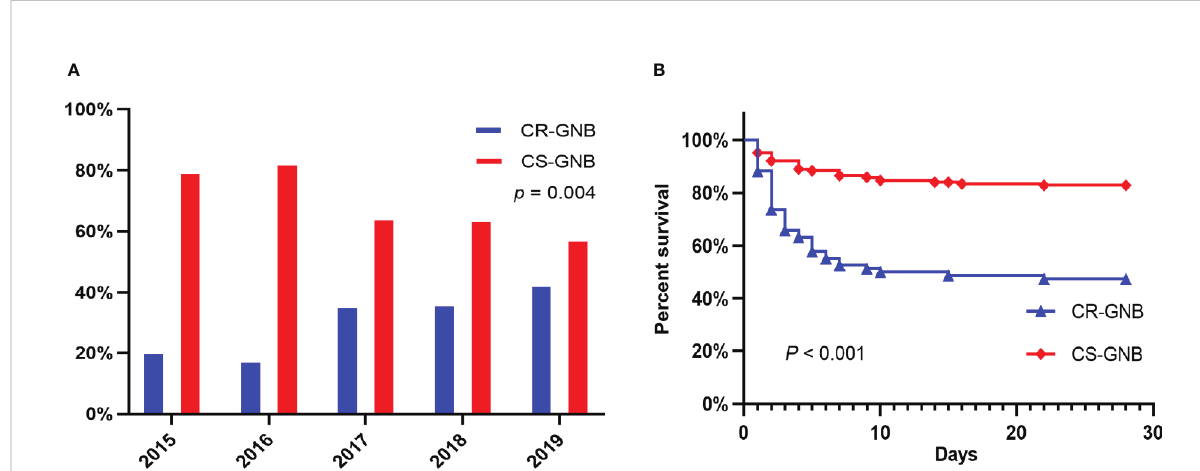
FIGURE 2 Percentages of Resistance to Carbapenems among Gram-negative bacteria during the Study Period (A) ; Kaplan-Meier Survival Analysis among Hematological Patients with BSI caused by Carbapenem resistant (CR) and carbapenem susceptible (CS) Gram-negative bacteria (B) .